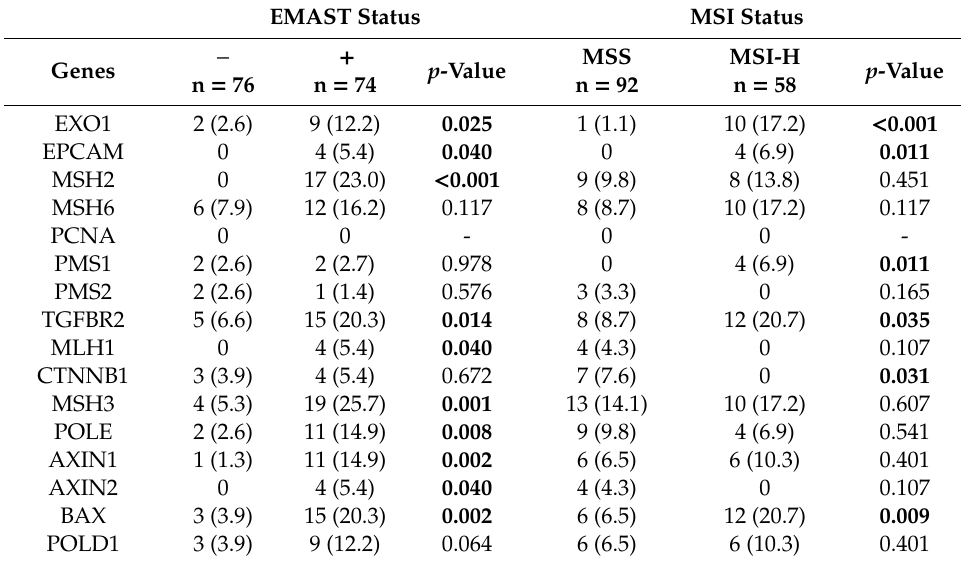
Table 3. Genetic mutations using NGS method, according to the EMAST and MSI